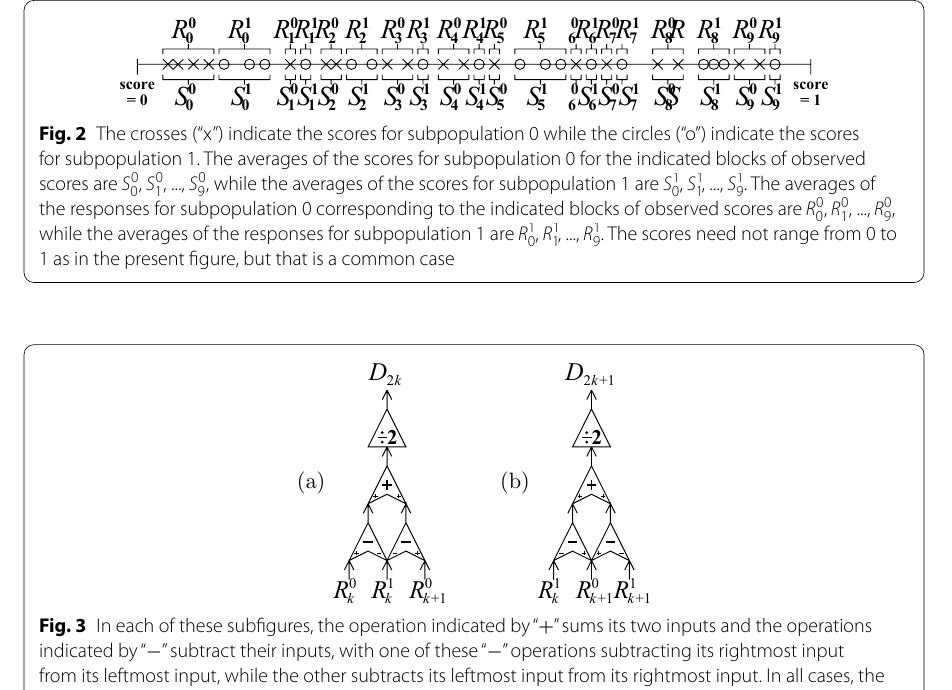
6. Graph as a function of j / n the sequence of cumulative average differences